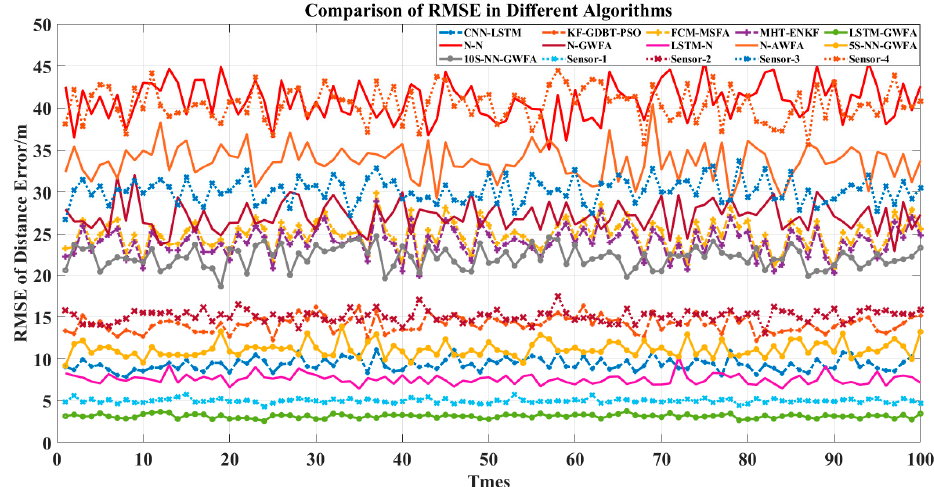
Figure 3. Comparison of RMSE with 100 tracks in different algorithms.